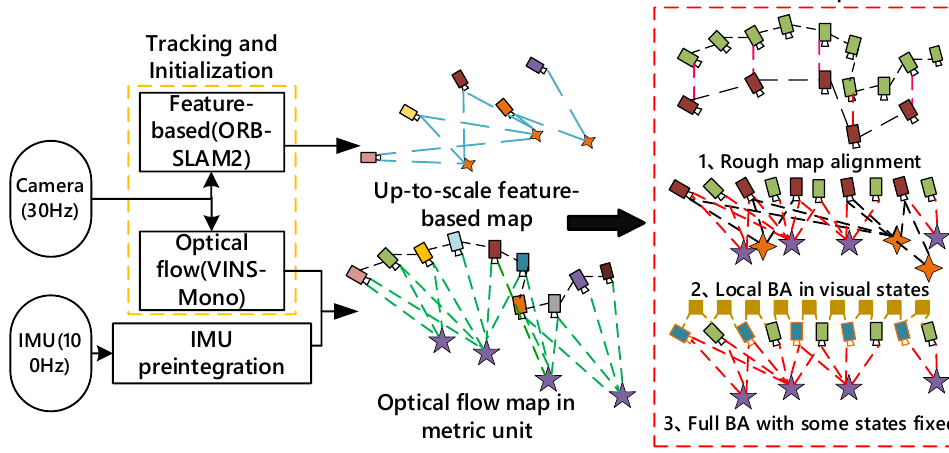
Figure 1. The framework of the robust parallel initialization methods.